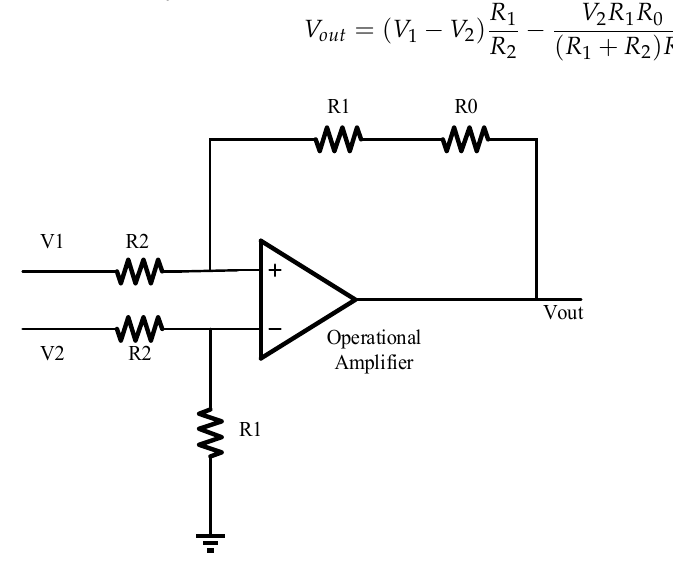
Figure 14. The improvement of the output offset